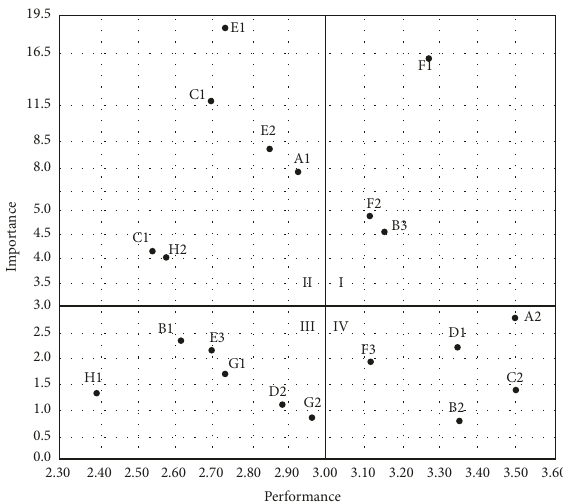
Figure 5: Management efficiency of sports events before and after optimization.